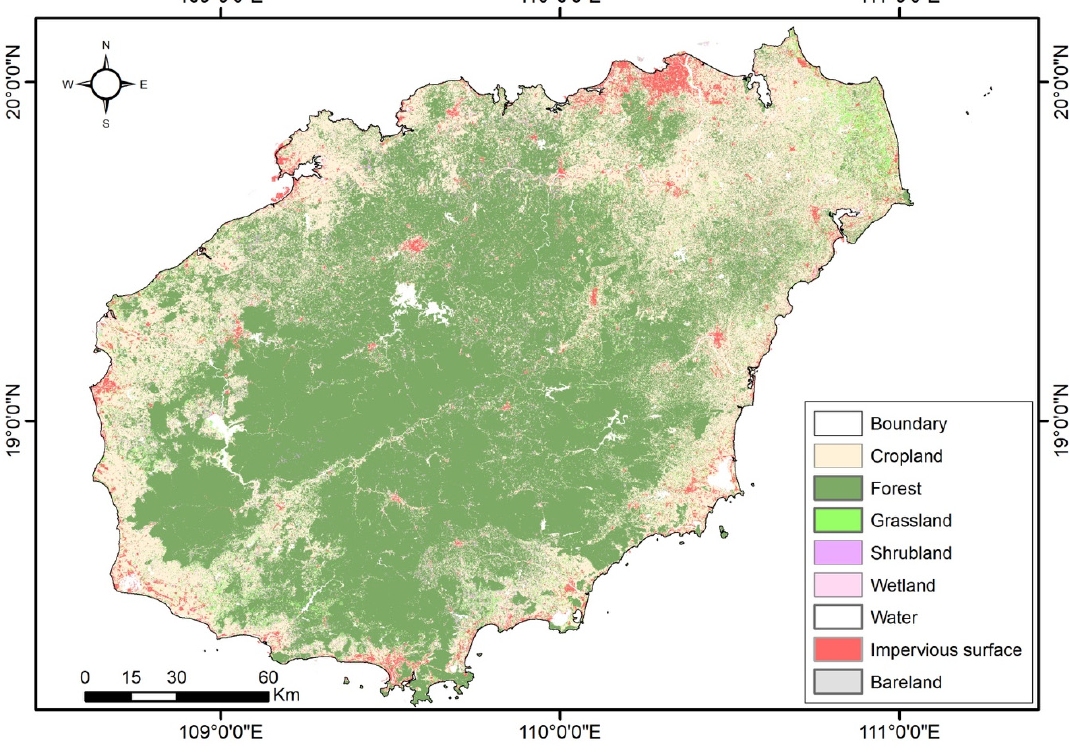
Figure 8. The land use/land cover on Hainan Island (data source: Finer Resolution Observation and Monitoring - Global land cover dataset 2017 v1 version [53]). Monitoring—Global land cover dataset 2017 v1 version